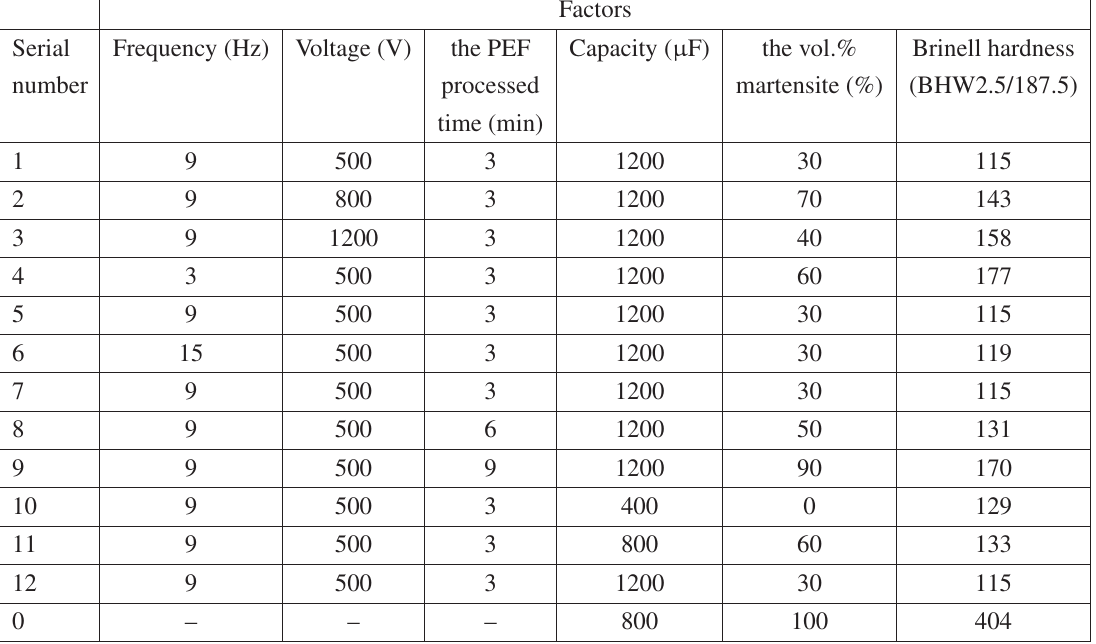
Table 2. Parameters and results of